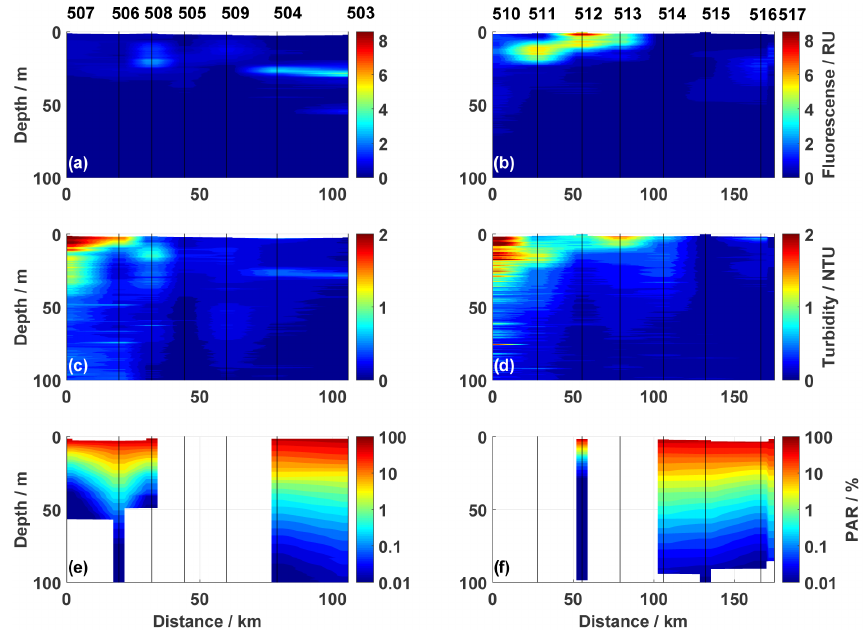
Figure 3. Bio-optical conditions in the Uummannaq Fjord (left, a , c and e ) and in Vaigat–Disko Bay (right, b , d and f ). The Chl a fluorescence is shown at the top, turbidity in the middle and PAR in % of surface PAR at the